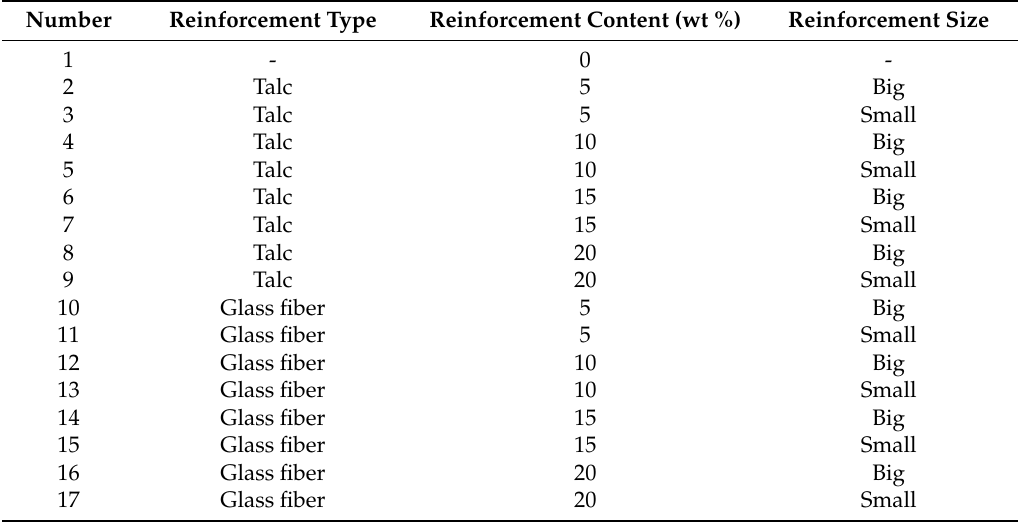
Table 2. Experimental